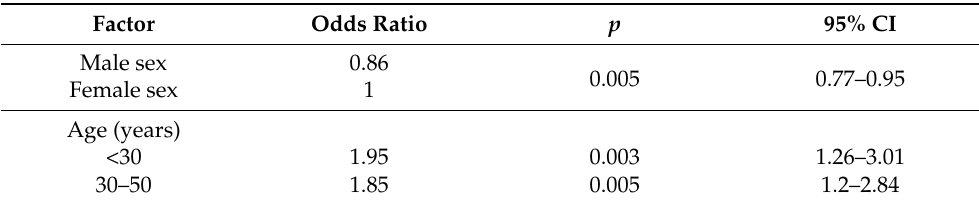
Table 4. Multivariate analysis of risk factors for minor low anterior resection syndrome (LARS) score of whole population.